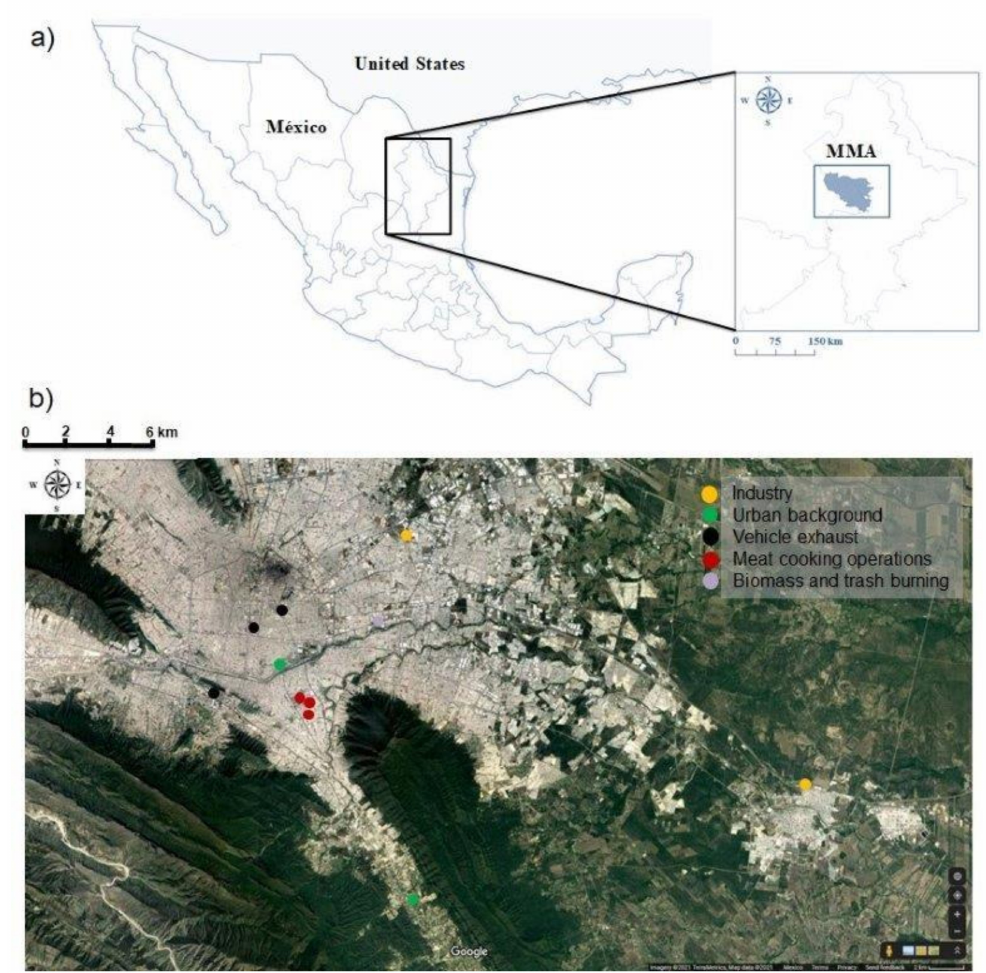
Figure 1. ( a ) General geographic location of the study area; ( b ) sampling points for every source profile (source: Google